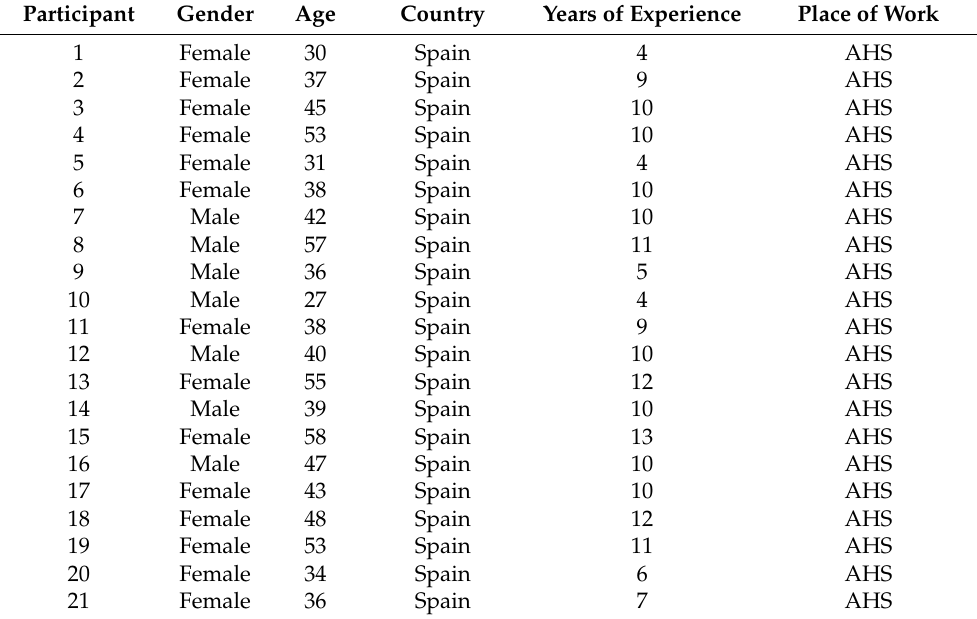
Table 1. Sociodemographic characteristics of the participants (N =